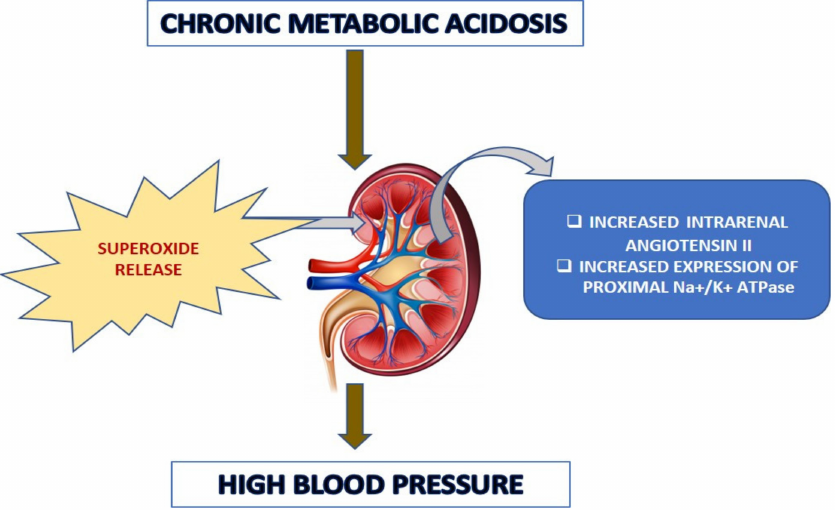
Figure 13. Schematic representation of possible pathophysiological routes of acidosis-induced increased blood